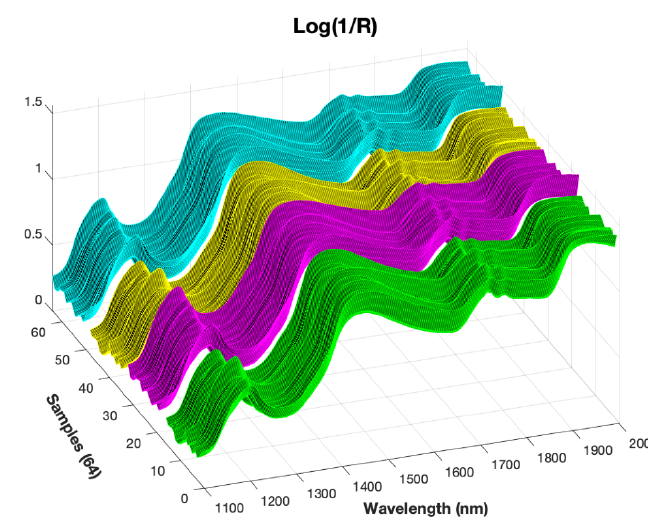
Figure 2. NIR measurements (spectra) for the whole sample set in the wavelength range 1100–2000 nm. Four colors are used to distinguish the spectra according to the aging and seasons of the cheese (4 months/Winter-Green, 6 months/Winter-Magenta, 4 months/Summer-Yellow, 6